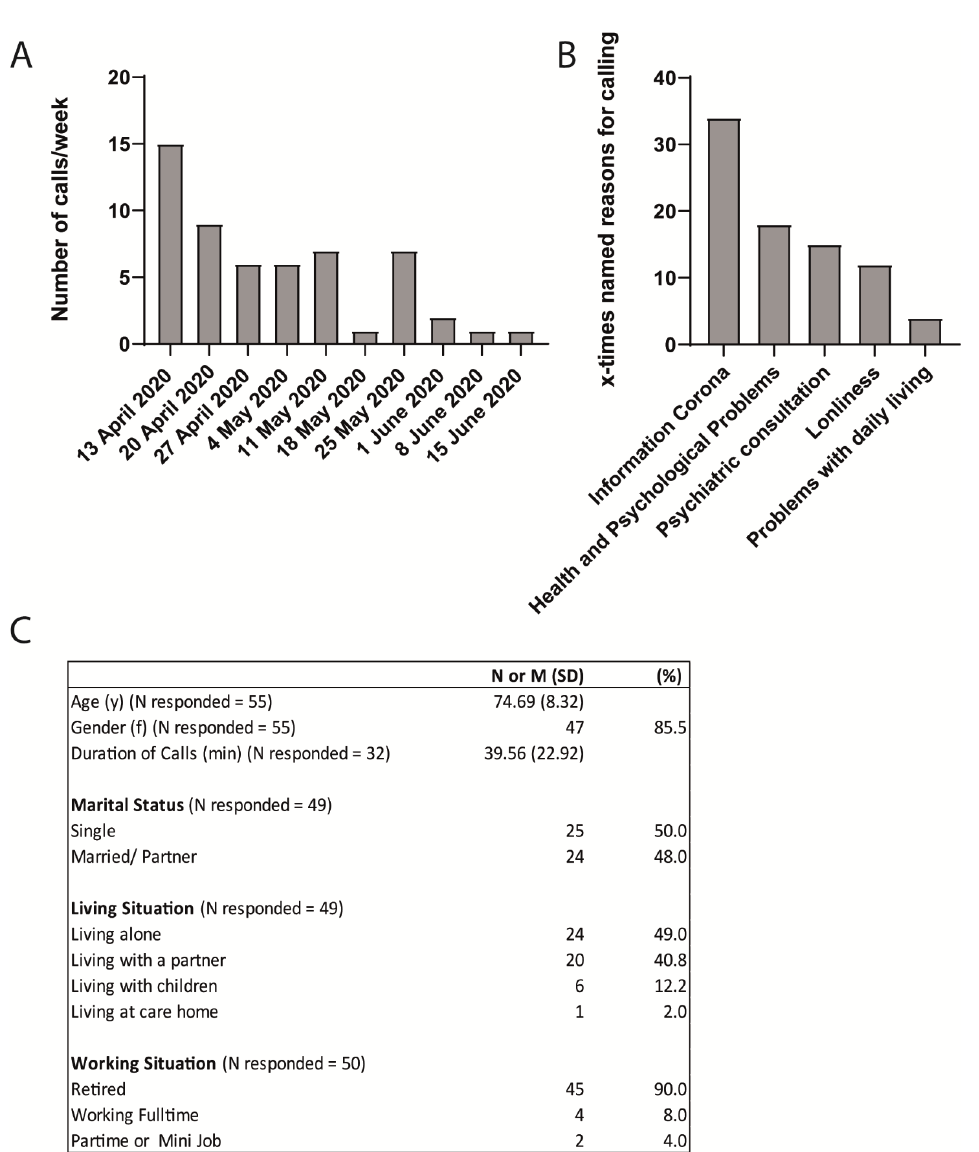
Figure 1. ( A ) Histogram showing the frequency of calls/week received at the geriatric helpline. ( B ) Graph depicting the reasons for calling the geriatric helpline. ( C ) Demographic characteristics of callers. N responded = the number of callers who were willing to answer the question. N represents the number of callers who affirmed the specific information and features asked. The percentage was calculated as (N/N responded) × 100.